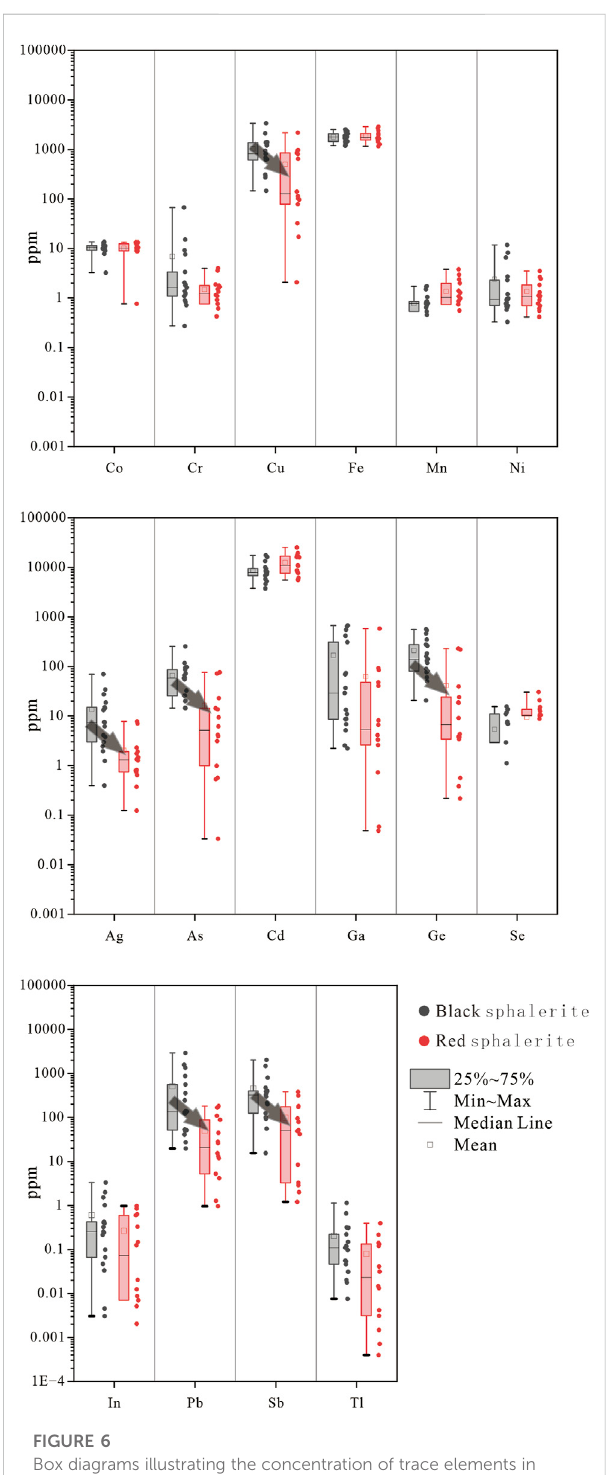
FIGURE 6 Box diagrams illustrating the concentration of trace elements in sphalerites from the Fuli Pb-Zn deposit.